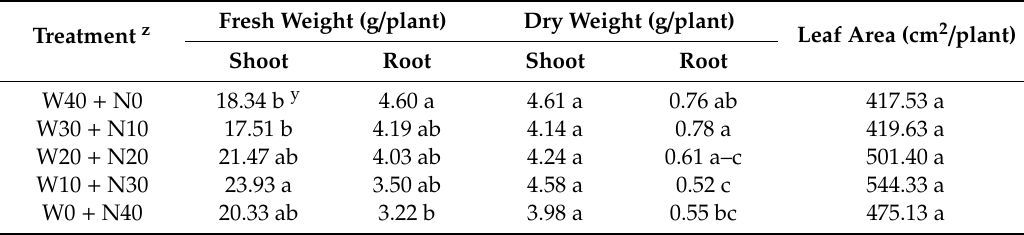
Table 4. The fresh and dry weights and leaf area of “Maehyang” strawberry runner plants a ff ected by the nutrient solution resupply period during the nursery stage ( n =